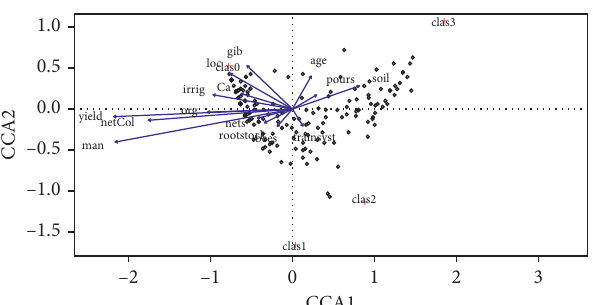
Figure 3: Canonical correlation analysis (CCA) of superficial scald classes of “Abate Fetel” pear (clas0 0%, clas1 1%–25%, clas2 26–50%, and clas3 51–100% of peel symptoms) against qualitative orchard features (blue vectors) and the scores of producers (black circles) in two seasons (2018-2019 and 2019-2020). Total variability explained (18%): CCA1 (93%); CCA2 (4%). The following abbreviations have been used: geographical position (loc) near the Adriatic sea (1) or far from Adriatic sea (0), use bees or pollinators (bees) yes (1) or no (0), use of organic matter (org) yes (1) or no (0), age of the orchard (age) < 10 years (1) ≥ 10 years, use of gibberellins (gib) yes (1) or no (0), presence antihail nets (nets) yes (1) or no (0); rootstock (rootstock) weak (1) or strong (0), type of soil (soil) with abundant clay (1) or sand (0), type of irrigation (irrig) below canopy (1) or above canopy (0), training system (trainsyst) such as fruit wall (1) or spindle (0), use of calcium (Ca) yes (1) or no (0), origin of the organic matter used (man) cow manure (1) or poultry manure (0), heavy downpours (pours) during the season yes (1) or no (0), orchard average productivity (yield) ≤ 30t/ha (1) or > 30t/ha (0), and presence of coloured nets or no-nets (netCol) yes (1) or no